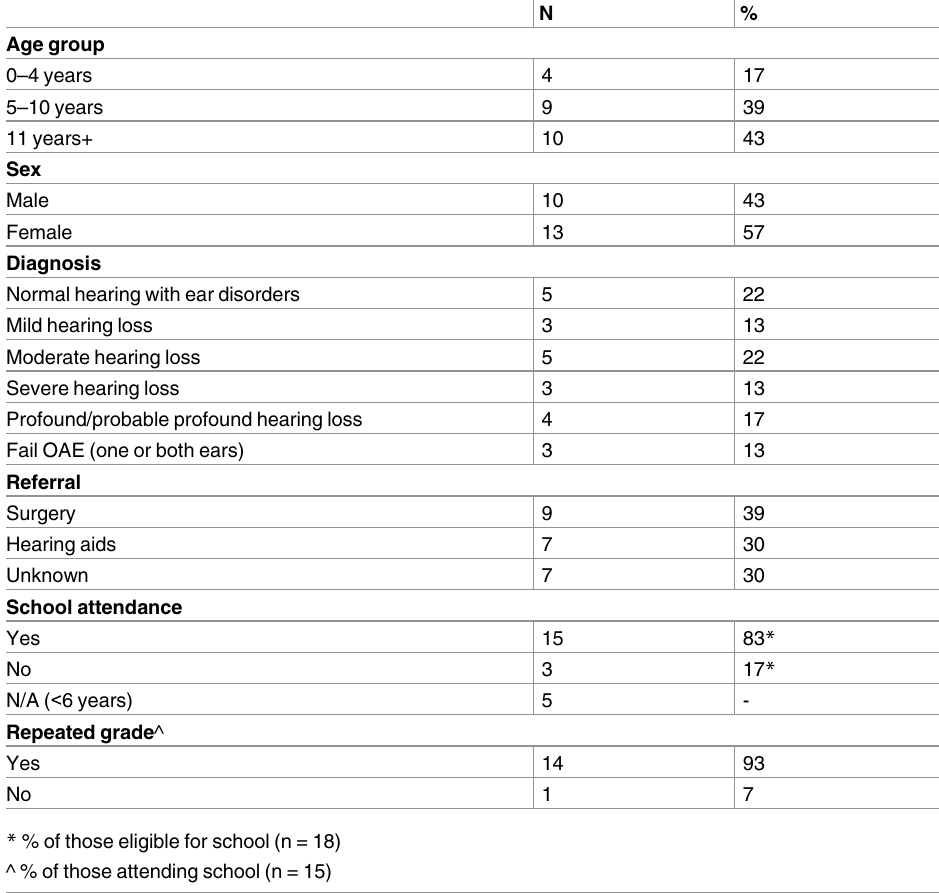
Table 2. Characteristics of children in qualitative study (n = 23).